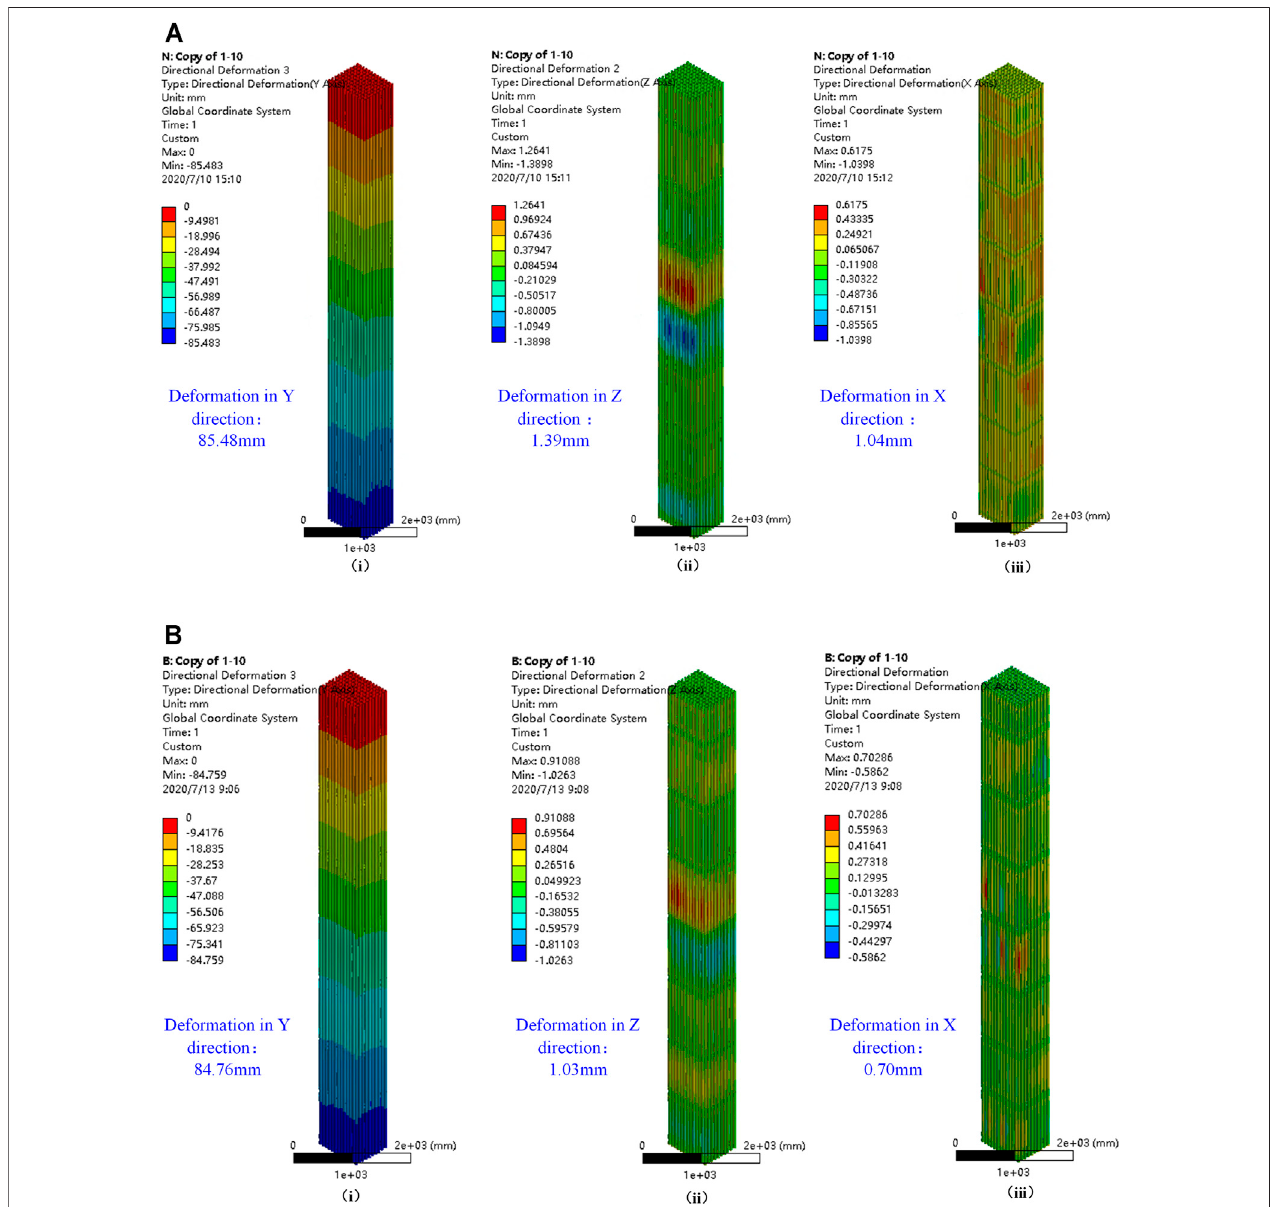
FIGURE3| Deformationoftheheatexchangetubebundle: (A) withoutgridand (B) withgrid. (i) Deformationinthe Y direction, (ii) Deformationinthe Z direction, (iii) Deformation in the X direction.